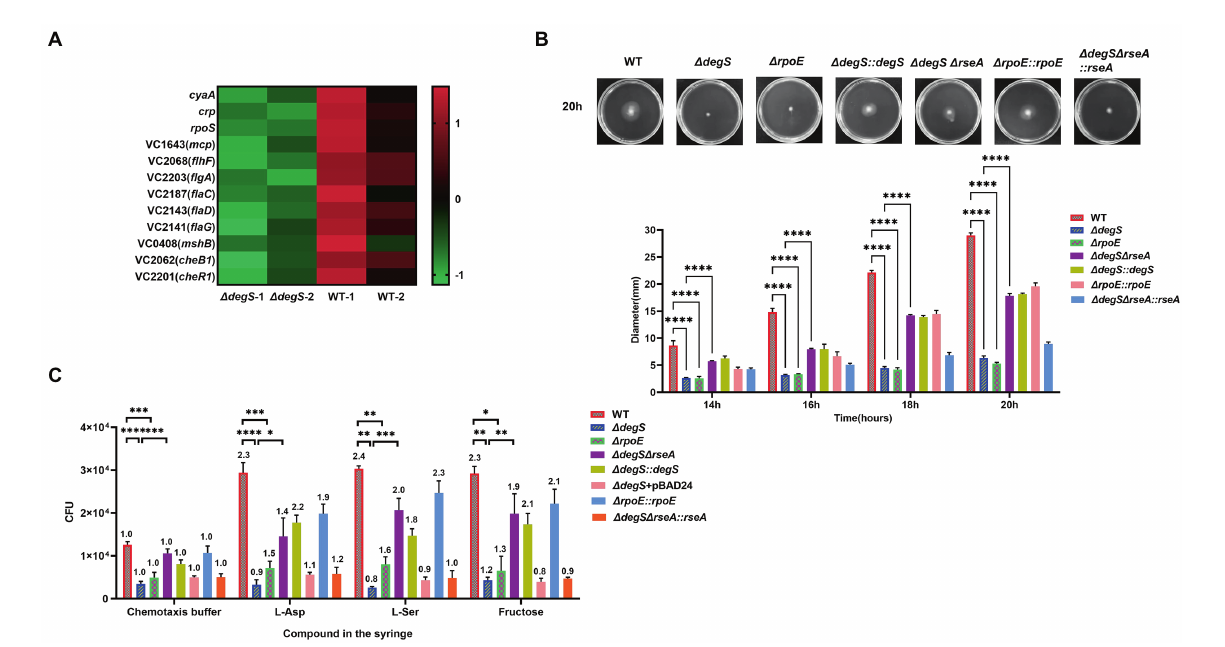
FIGURE 1 The positive regulation of Vibrio cholerae motility by DegS is partially dependent on σ E . (A) RNA-Seq analysis of differentially expressed genes in Δ degS and wild-type (WT) strains reveled that crp , cyaA , rpoS, and nine motility-related genes were downregulated in Δ degS strains. (B) The swimming motility of the WT, Δ degS , Δ degS::degS , Δ rpoE , Δ rpoE::rpoE , Δ degS Δ rseA , and Δ degS Δ rseA::rseA strains were assessed on soft agar plates. The representative pictures for the swimming zones are obtained at 20 h. Data were analyzed using a two-way ANOVA. ****, p < 0.0001 between two strains. (C) Analysis of the chemotactic responses to aspartate, serine, and fructose by the WT, Δ degS , Δ degS::degS , Δ degS + pBAD24, Δ rpoE , Δ rpoE::rpoE , Δ degS Δ rseA , and Δ degS Δ rseA::rseA strains. Error bars indicate the SDs based on three replicated experimental values ( n = 3). *, p < 0.05; **, p < 0.01; ***, p < 0.001; and ****, p < 0.0001 between two strains (two-tailed unpaired t -tests). Numbers on top of each bar indicate the relative chemotactic indexes